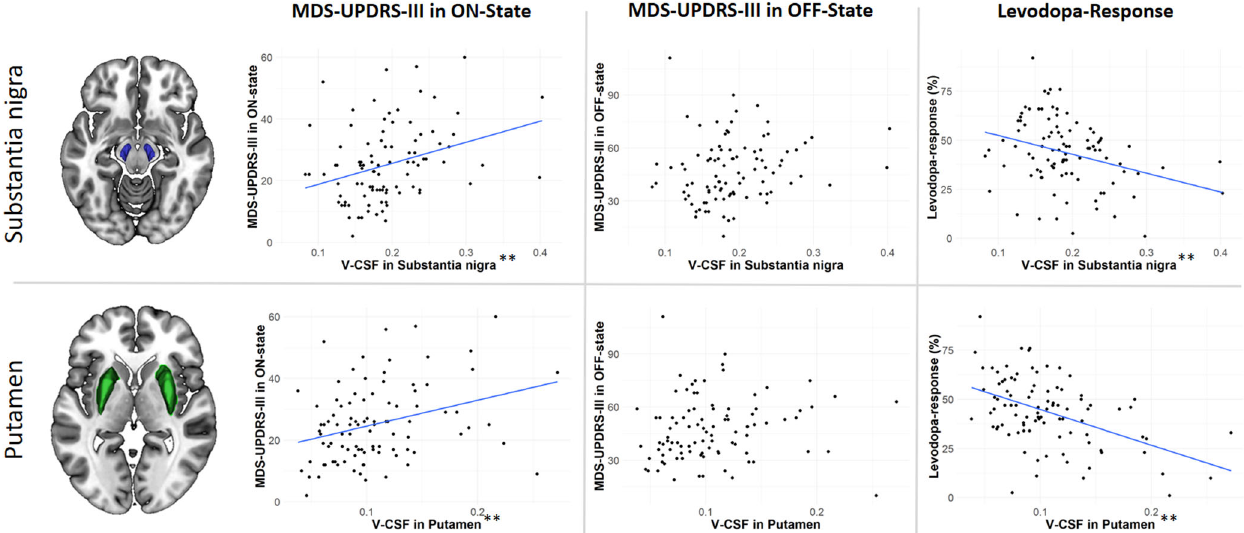
Fig. 4 Association of nigral and putaminal microstructure with motor impairment and levodopa response. Association between V-CSF in the substantia nigra and putamen with clinical parameters. Dot plots illustrate the association between nigral V-CSF (top row) and putaminal V-CSF (bottom row) with MDS-UPDRS III in the ON-state, MDS-UPDRS-Part III in OFF-state, and the levodopa response. Each dot represents a single patient. A regression line is shown in blue. Signi fi cance threshold: ** p <